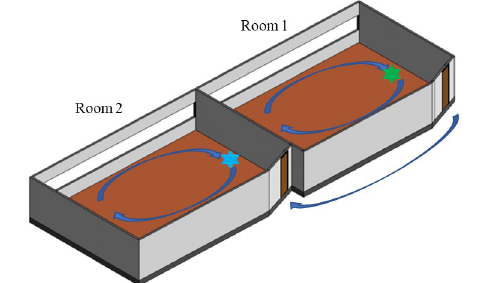
Figure 4: An outdoor scene corresponding to the indoor/outdoor interface of a sloped street.